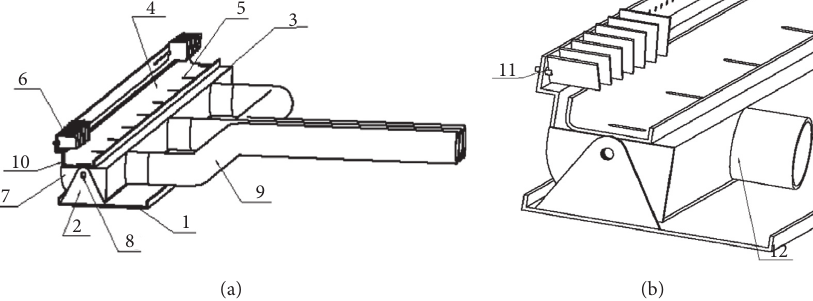
Figure 5: Injection box structure of air curtain forcing device. (1) Bottom plate; (2) support piece; (3) forcing cavity fixed plate; (4) movable injection cavity top plate; (5) adjusting nut; (6) air guide piece; (7) injection cavity; (8) rotary support shaft; (9) air duct; (10) injection nozzle; (11) air guide blade adjustment shaft; (12) air supply nozzle.